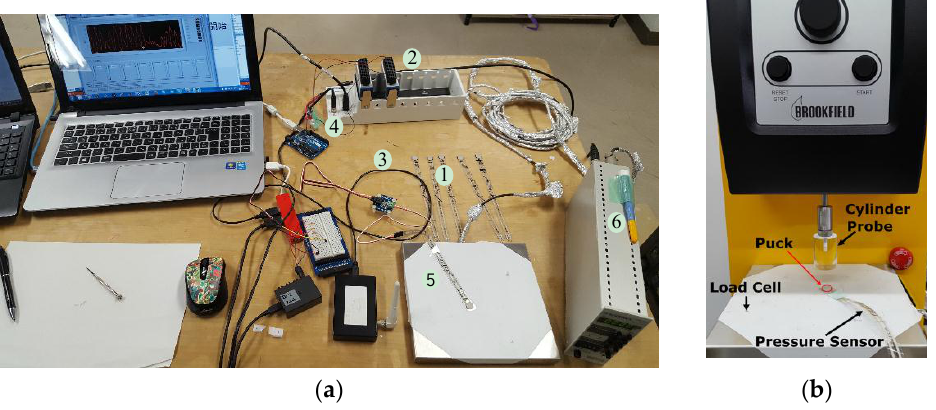
Figure 1. ( a ) The experimental setup conditioning of the FlexiForce sensor for the measurement system; ( b ) The CT3 Texture Analyser for evaluation of the pressure sensor.